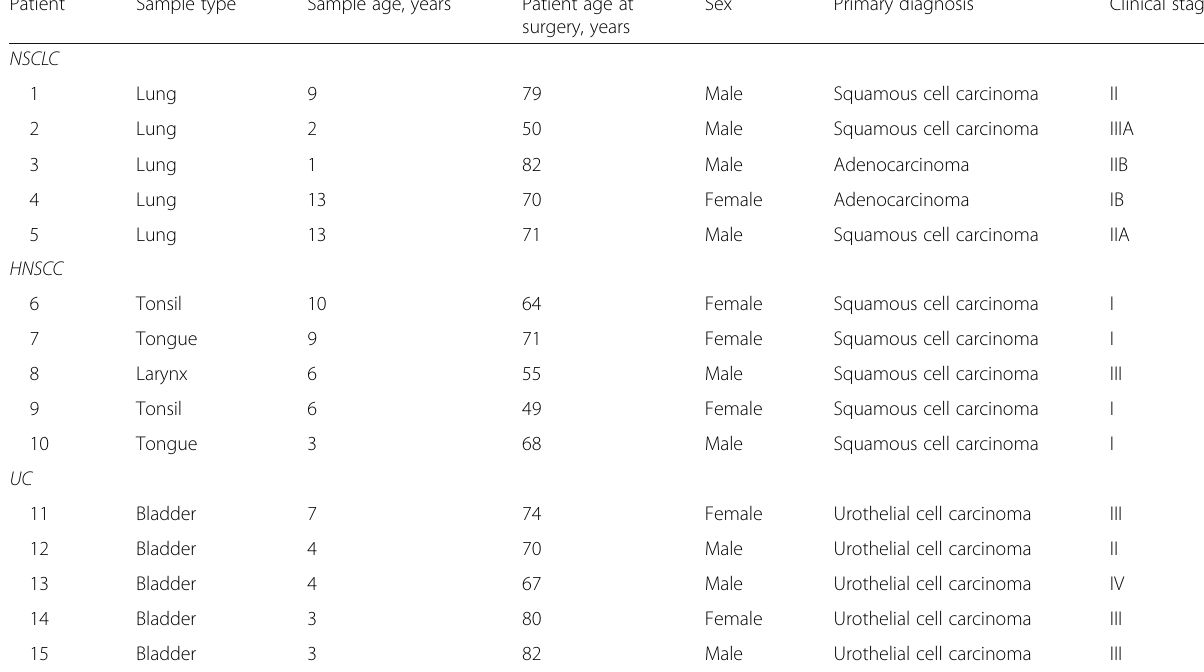
Table 2 Demographics of patients who provided samples for analysis